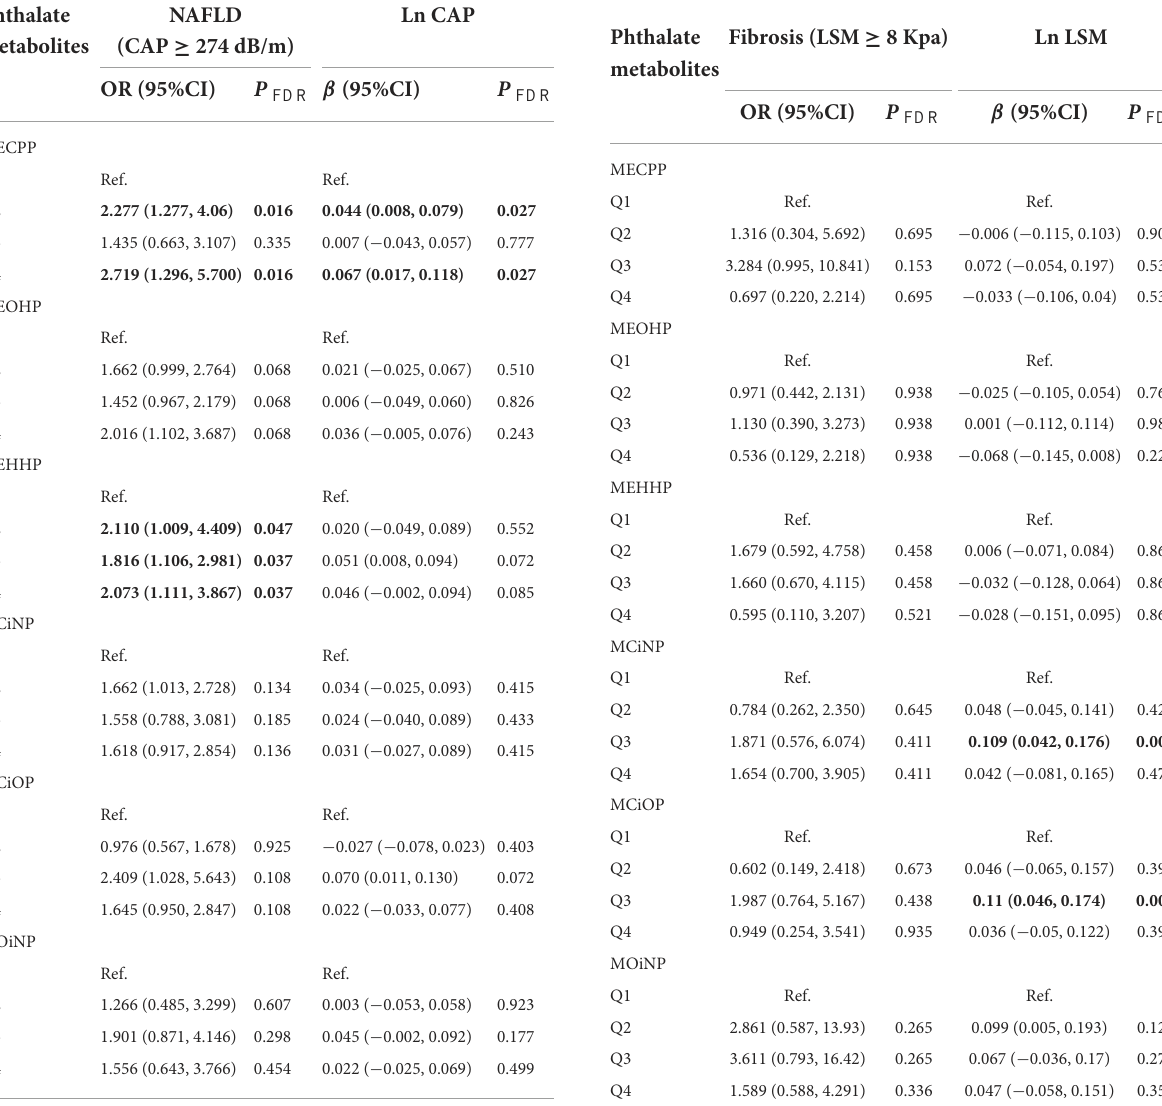
TABLE 3 The associations between phthalates and NAFLD in US adults. TABLE 4 The associations between phthalates and liver fibrosis in US